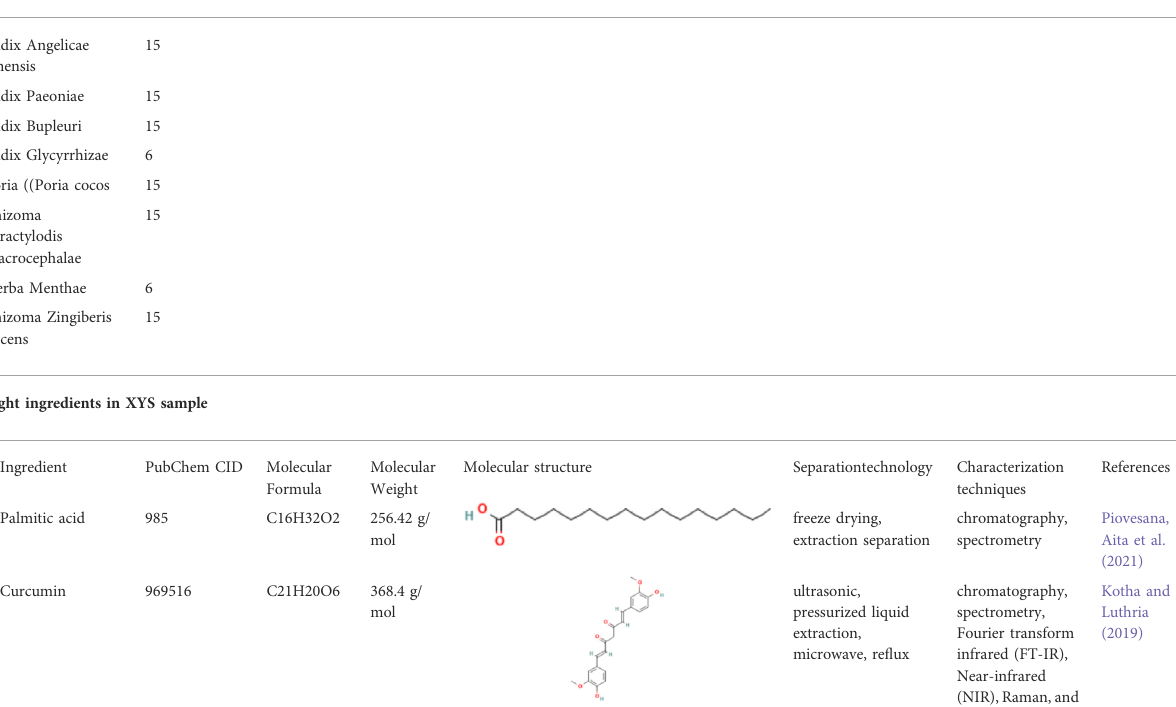
TABLE 1 Composition of XYS and Eight ingredients in XYS sample (XYS is derived from “ Taiping Huimin Heji Jufang ” and is composed of these eight Chinese medicines) (Ding et al., 2017a). Medicinal plant